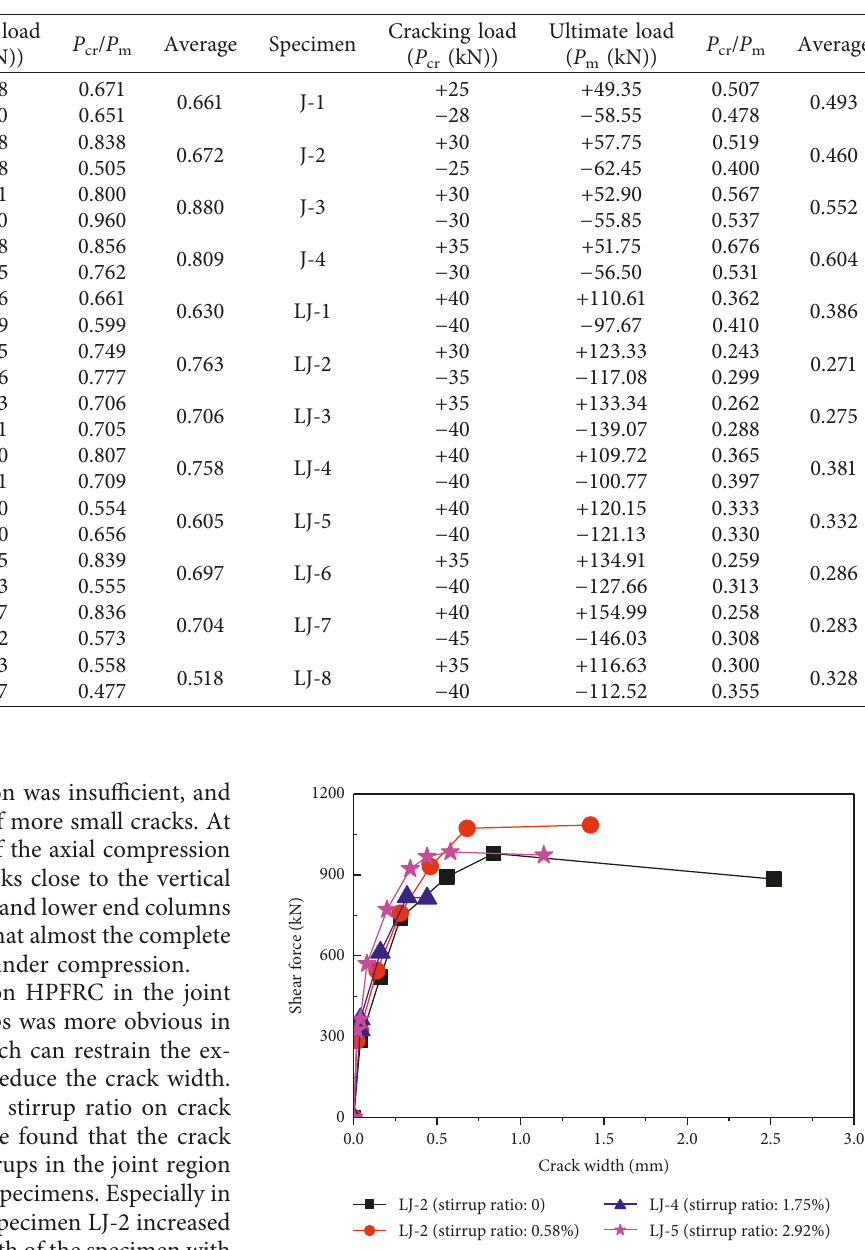
Figure 3: The influence of the stirrup ratio in the joint region on crack width.